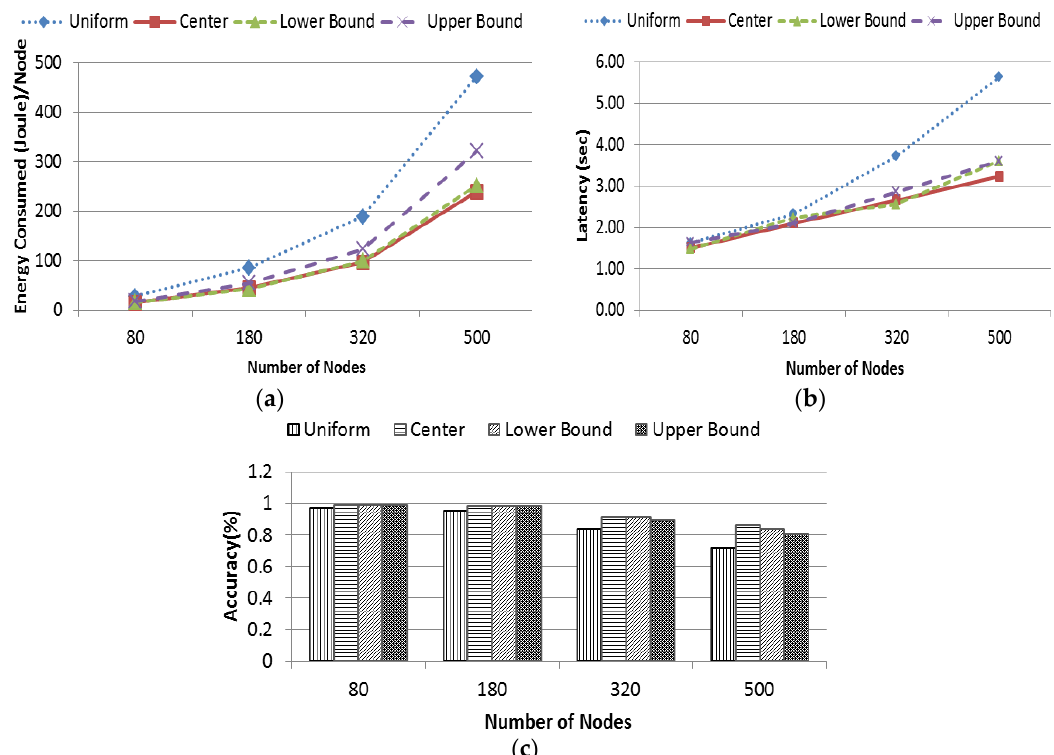
Figure 15. ( a ) Energy consumption; ( b ) latency; and ( c ) accuracy.